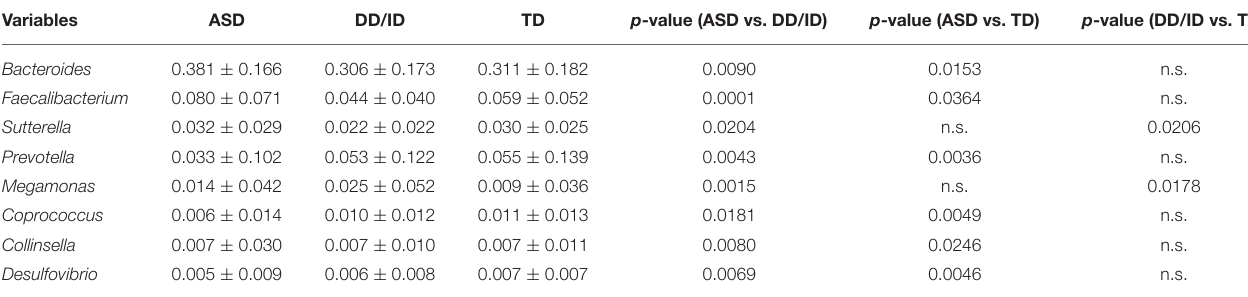
TABLE 2 | Relative abundance of bacteria in fecal microbiota of children with ASD, DD/ID, and TD. Variables ASD DD/ID TD p -value (ASD vs. DD/ID) p -value (ASD vs. TD) p -value (DD/ID vs.